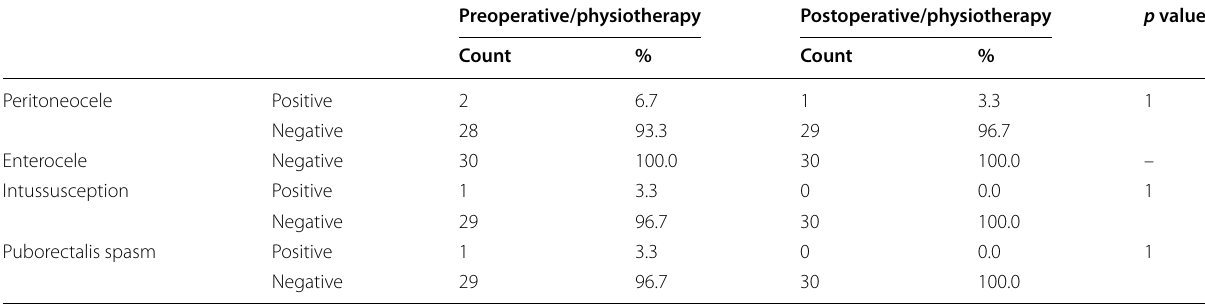
Data are expressed as number (%) p < 0.05 =